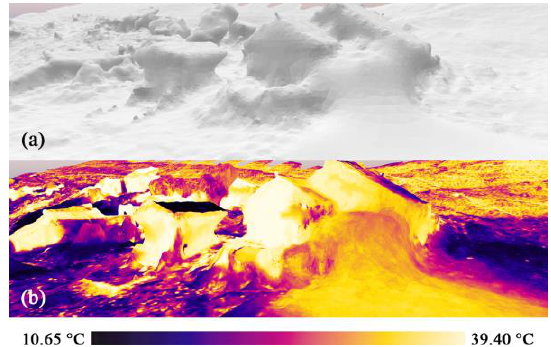
Figure 11. (a) Mesh triangulated from thermal dataset and (b) Texturized mesh (thermal data, IRON palette).